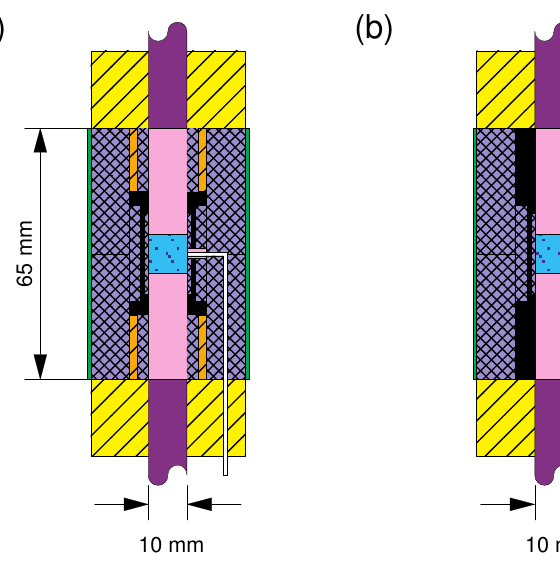
Figure 4. Cross-sectional view of solid-medium assemblies used in ( a ) Masuda and Fujimura [4] and ( b ) this